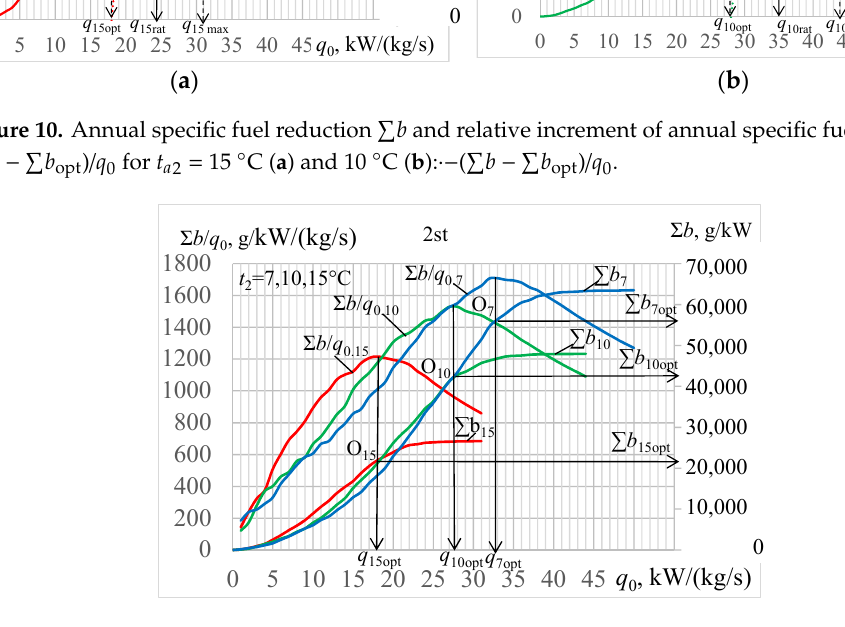
Figure 11. Relative increment of annual specific fuel reduction ∑ b / q 0 and annual specific fuel reduction ∑ b due to cooling air to t a 2 = 7, 10 and 15 °C against a cooling capacity needed q 0 (2 stage of methodology).